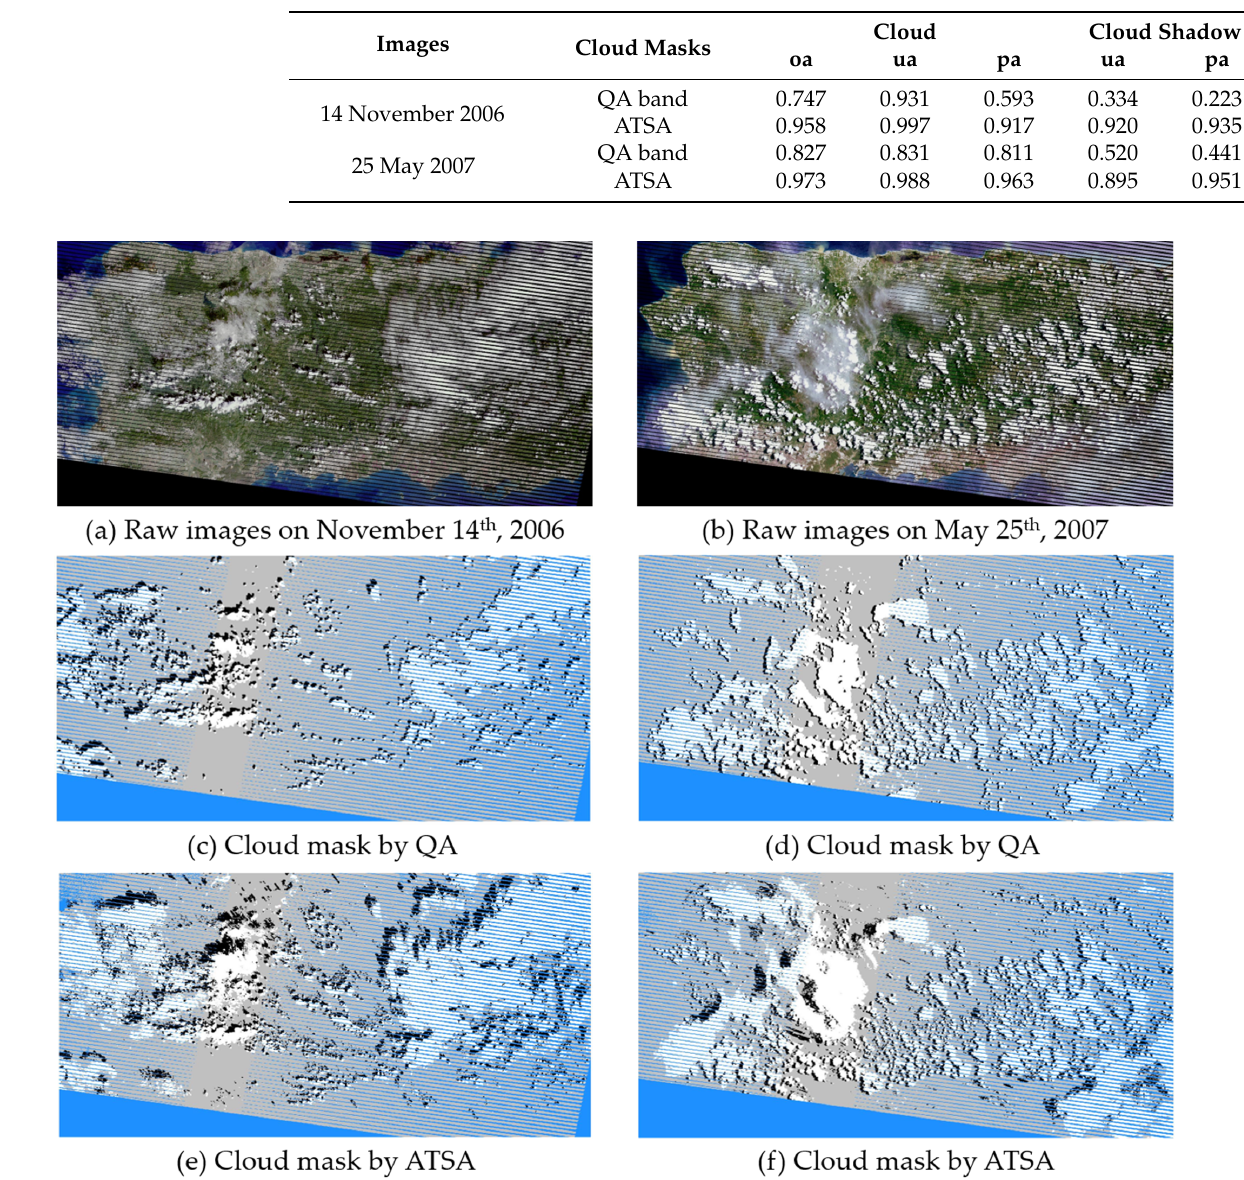
Figure 8. Two true-color raw Landsat-7 images on 14 November 2006 ( a ) and 25 May 2007 ( b ) over the main island of Puerto Rico, and the corresponding cloud and shadow masks extracted by Landsat cloud QA band ( c , d ) and ATSA method ( e , f ). The write, black, and blue in the masks are clouds, shadows, and gaps. To quantitatively assess the accuracy of contaminated pixel interpolation, we selected a cloud-free subset from our collected Landsat time series as a reference image (Figure 9a, its location is marked by a box in Figure 1). Then, to simulate a cloudy image, we added to this reference image gaps, clouds, and shadows extracted from a cloudy image (Figure 9b). For this simulated cloudy image, its real pixel values were used to assess the accuracy of cloud removal and gap filling by NSPI (Figure 9c). We can see that nearly all gaps, clouds, and shadows were successfully removed by the NSPI method. The repaired image has high-quality visuals. The repaired pixels have high consistency with surrounding clear pixels, and the places with clouds and shadows are nearly invisible in the recon- structed image, suggesting that the reconstructed image has high accuracy. The scatter plot between actual and predicted values for the NIR band (Figure 9d) also demonstrates the high accuracy of the NSPI interpolation results. The NIR band changes more with vegetation growth and so is more challenging to interpolate than other bands. The RMSE value is 0.015 and R 2 value is 0.887 for the NIR band in this simulation experiment, sug- gesting that the reconstructed images can reliably capture the vegetation dynamics.